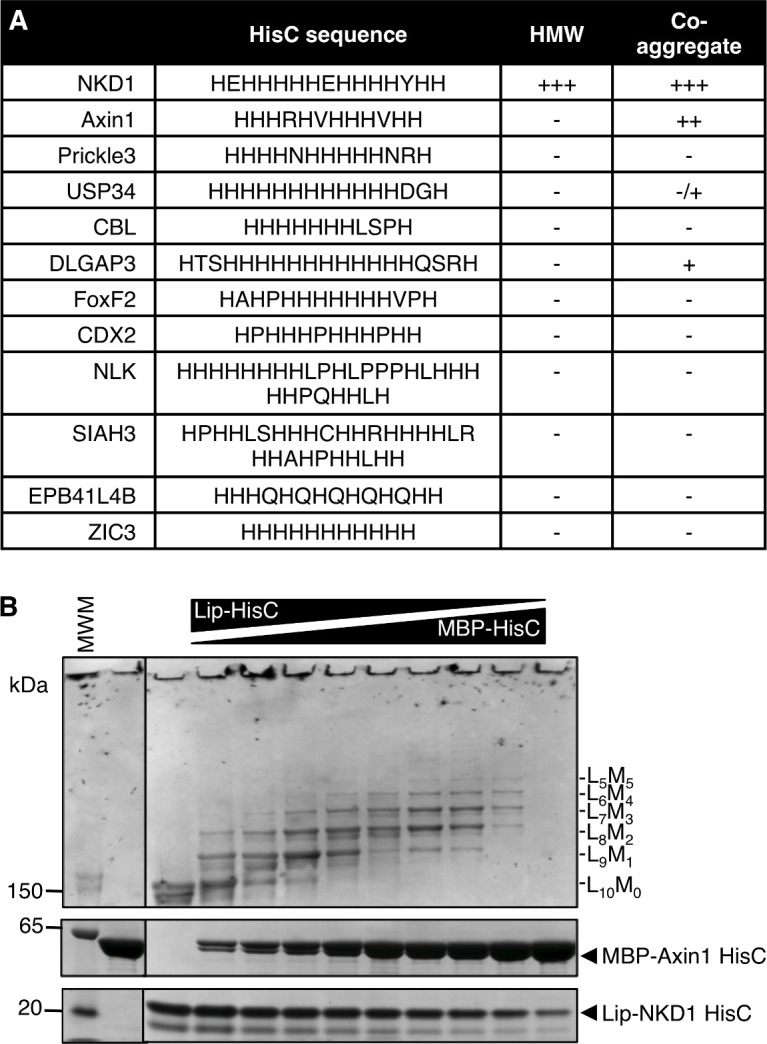
NKD1 HisC co-aggregates with Axin1 HisC.(A) Selected HisC-containing proteins in the human genome (see also text) and their ability to co-aggregate with NKD1 HisC. (B) Co-aggregation assays after mixing Lip-NKD-HisC and MBP-Axin1-HisC at different ratios (MWM, molecular weight markers).Figure 3—source data 1.HisC proteins in the human genome and their subcellular location.